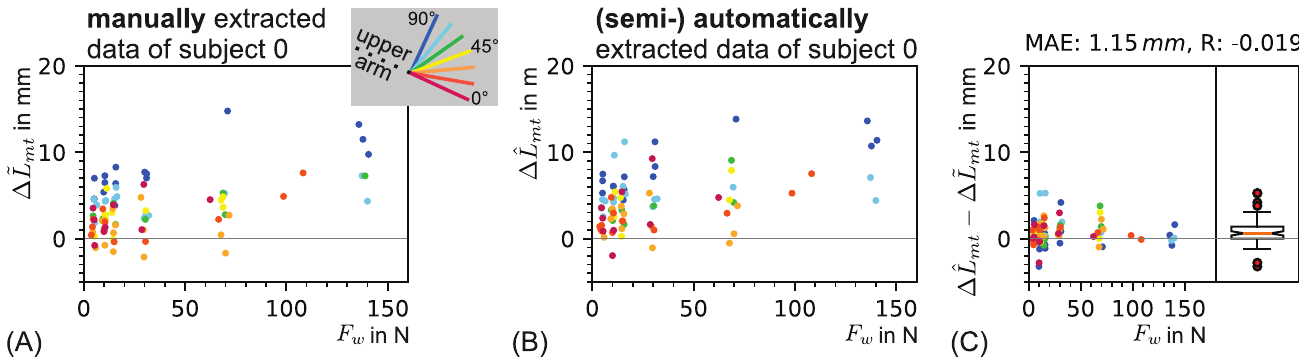
Fig 7. Tendon displacement over wrist force for all elbow angles is shwon in case of (A) manual and (B) (semi-) automatic data extraction, with (C) a as depicted in comparison of both methods. The length of the junction movement parallel to the bone of subject 0 is shown for the manually extracted data D ~ L mt (A) and for the automatically extracted data D ^ L in (B). In both cases the mytendinous junction movement parallel to the bone is shown over the wrist force F w for mt all elbow angles Θ (cmp. Eq (13)). The bone line angle as well as the evaluated frames are adopted from the manual evaluation as described in Eq (31). In (C) the difference between the automatically extracted data D ^ L and the manually extracted data D ~ L of subject 0 is shown. mt mt